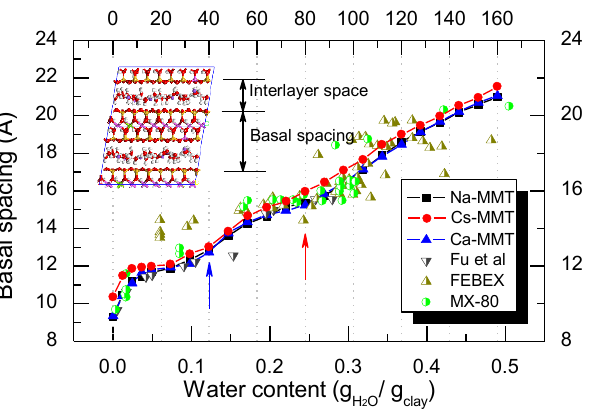
Figure 2. The simulated and experimental basal spacing of montmorillonite as a function of water content ( g denotes molecular mass).